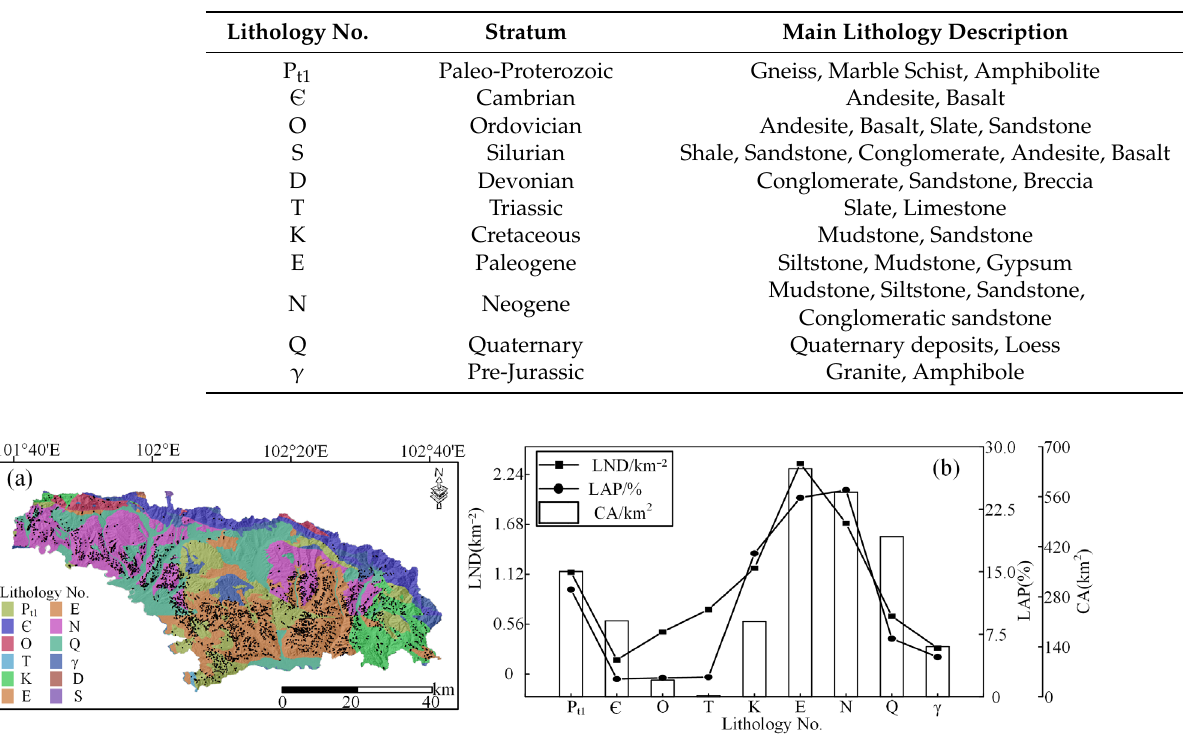
Figure 11. Relationship between lithology and landslide distribution. ( a ) Lithology distribution in the study area. ( b ) Statistics of landslide indicators in the lithology intervals. The farthest landslide from the faults occured at a distance of 15,040 m. Given that these distant faults only exert a limited impact on landslides, we combined the intervals above 10 km into a single interval, while the remaining intervals were set to 2 km. The statistical results are shown in Figure 12, in which the area in the region 0–2 km from the faults is very high, reaching 1094.1 km 2 . This is related to the widespread distribution of the fault, which to some extent causes the low LAP and LND values therein. The LND reaches its maximum (1.62 km −2 ) in the region that is 4–6 km from the faults, while the LAP reaches its maximum (24.52%) in the 8–10 km range.